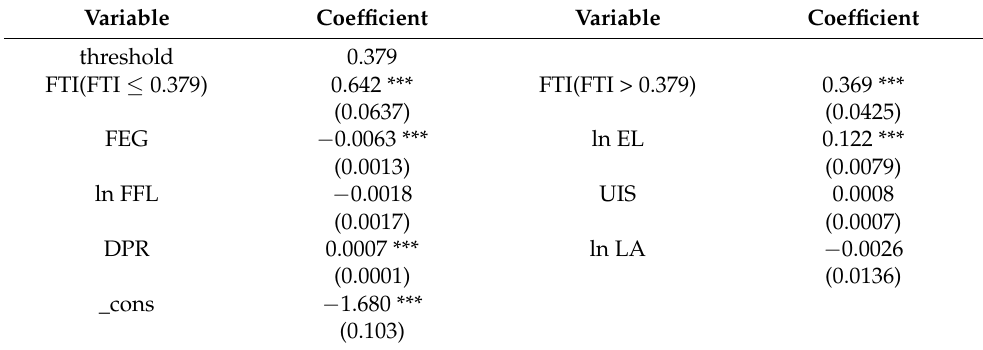
Table 11. Threshold regression